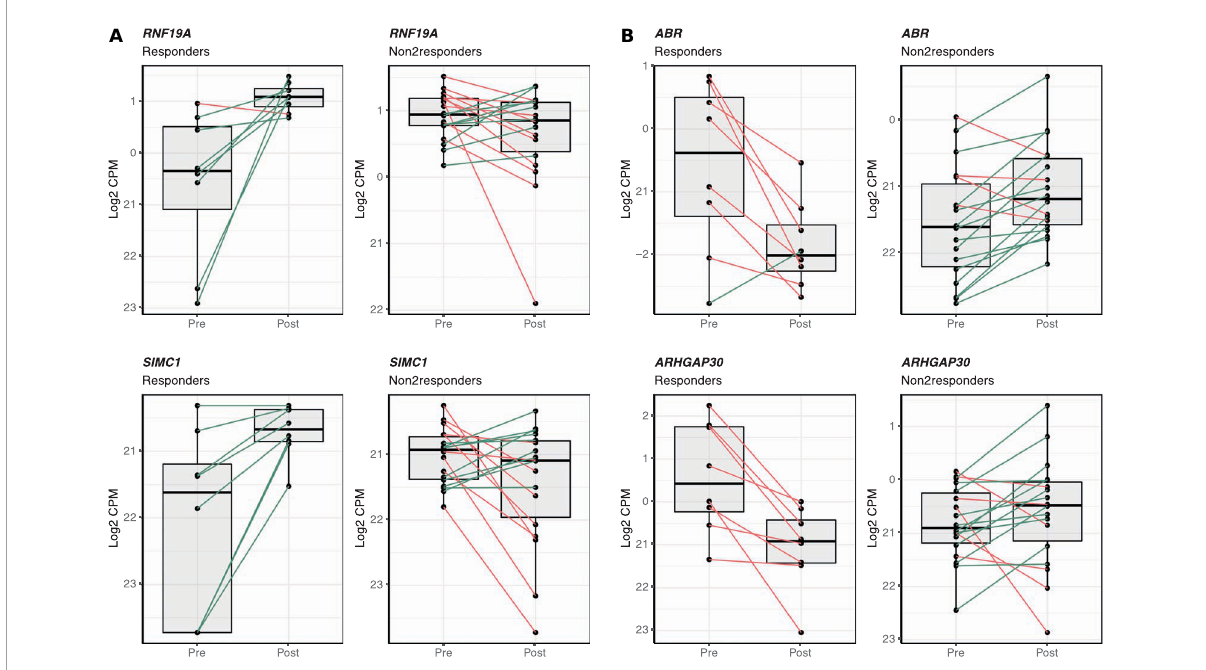
FIGURE2 Top differentially expressed transcripts in the responder sub-group following the mango consumption. Individual gene expression change between pre- and post-mango consumption visits is shown for responder and non-responder groups. (A) The two transcripts showing the most significant over-expression in the group of responders ( RNF19A and SIMC1 ) are shown on the two left columns. (B) The two transcripts showing the most significant under-expression ( ABR and ARHGAP30 ) are shown on the two right columns. Box and whisker plots show median, first, and third quartiles, and maximum and minimum values for the 26 matched participants before (Pre) and after (Post) the mango consumption. Green and red lines stand for increasing or decreasing gene expression levels between pre- and post-mango consumption visits within individual paired